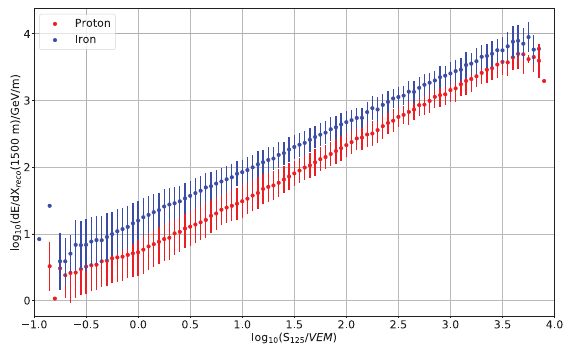
Figure 5: The composition sensitivity of the reconstructed energy loss parameter (dE / dX) at 1500 m slant depth for a given S 125 for H and Fe simulation [5] using Sibyll2.1 [4]. The error bars indicate the 1-sigma width of the (dE / dX) distribution for a given S 125 .